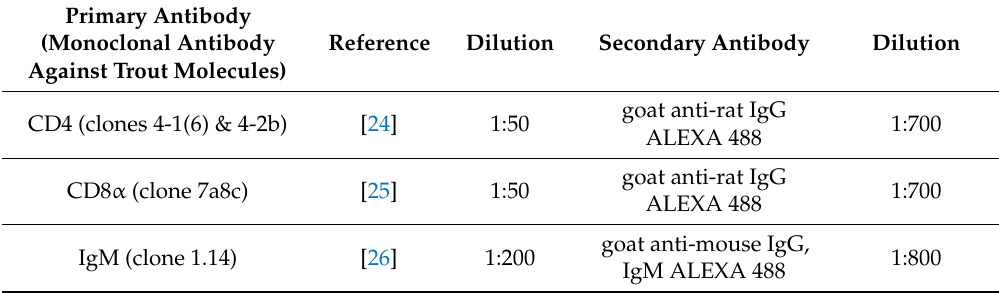
Table 2. Information on primary and secondary antibodies used for flow cytomety